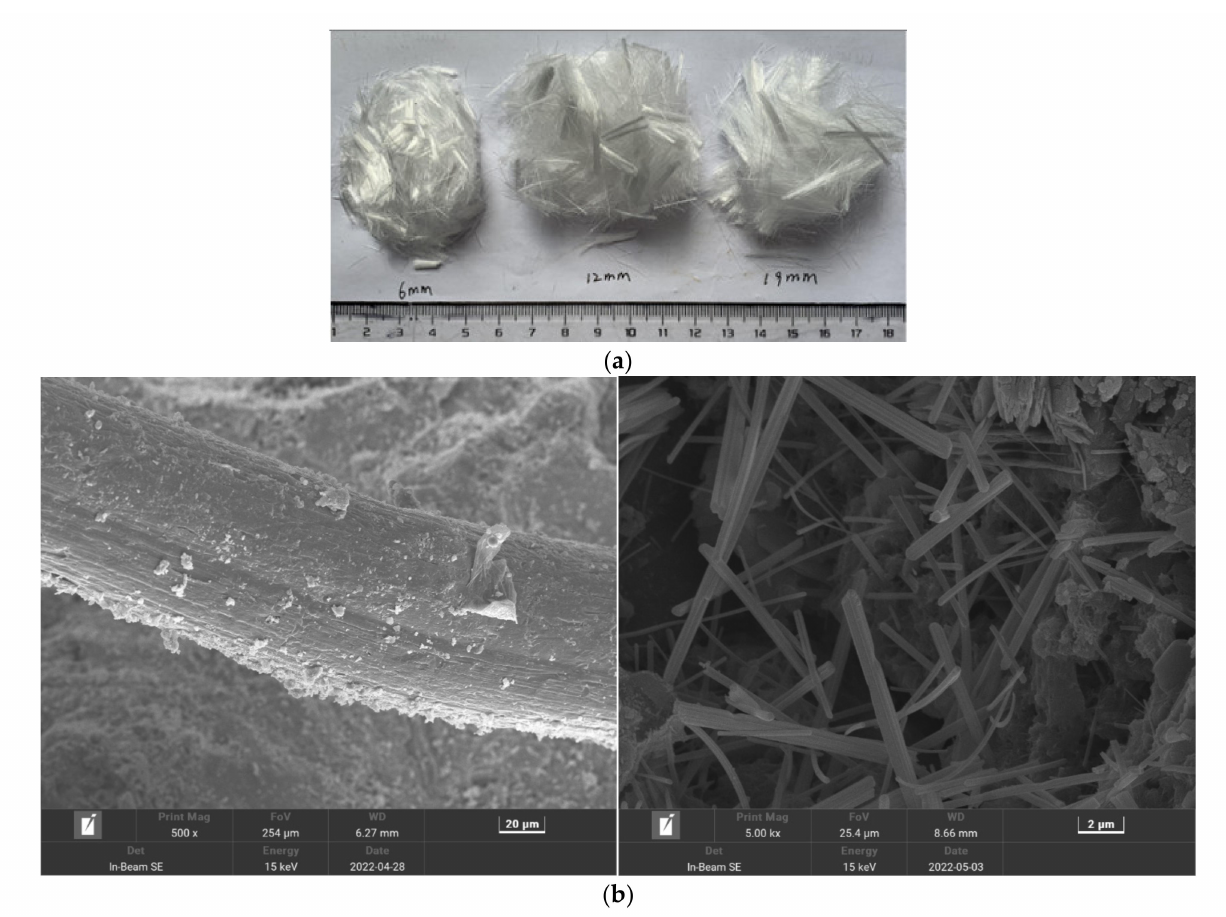
Figure 1. Cumulative sieve residue of fine sand.